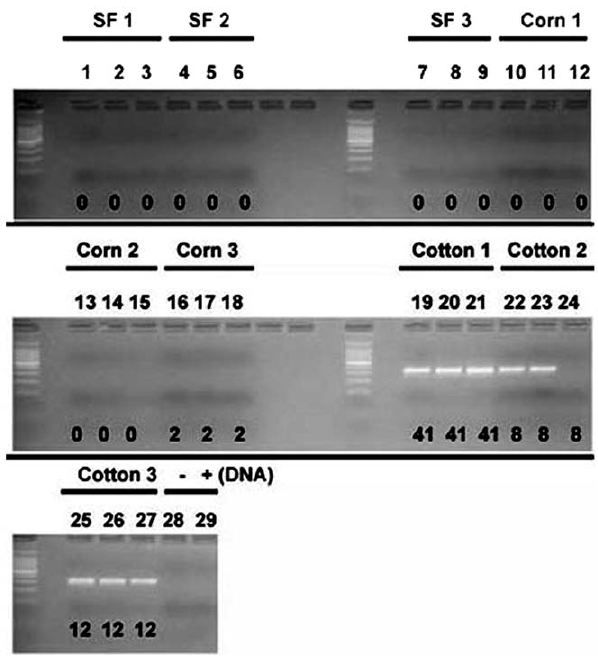
Figure 2. Amplification characteristics of the Rr- b -TUB qPCR primer on DNA isolated from R.reniformis extracted from the SF, Corn and Cotton sites under standard PCR conditions. The field sites are SF, Corn and Cotton. Each site was replicated in triplicate. The number of nematodes whose DNA was isolated is provided below the amplicon in each reaction. Lane 1, SF1; Lane 2, SF1; Lane 3, SF1; Lane 4, SF2; Lane 5, SF2; Lane 6, SF2; Lane 7, SF3; Lane 8, SF3; Lane 9, SF3; Lane 10, Corn 1; Lane 11, Corn 1; Lane 12, Corn 1; Lane 13, Corn 2; Lane 14, Corn 2; Lane 15, Corn 2; Lane 16, Corn 3; Lane 17, Corn 3; Lane 18, Corn 3; Lane 19, Cotton 1; Lane 20, Cotton 1; Lane 21, Cotton 1; Lane 22, Cotton 2; Lane 23, Cotton 2; Lane 24, Cotton 2; Lane 25, Cotton 3; Lane 26, Cotton 3; Lane 27, Cotton 3; Lane 28, No DNA; Lane 29, No